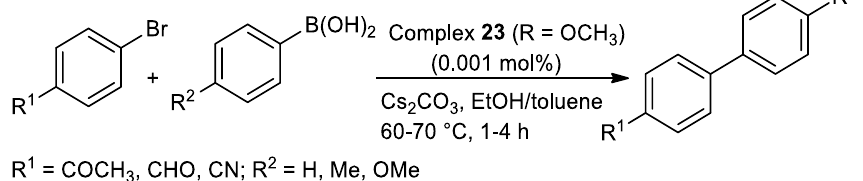
Figure 4. Representative metal complexes of thiosemicarbazones as catalysts for the Suzuki – Miyaura and other coupling reactions (Part